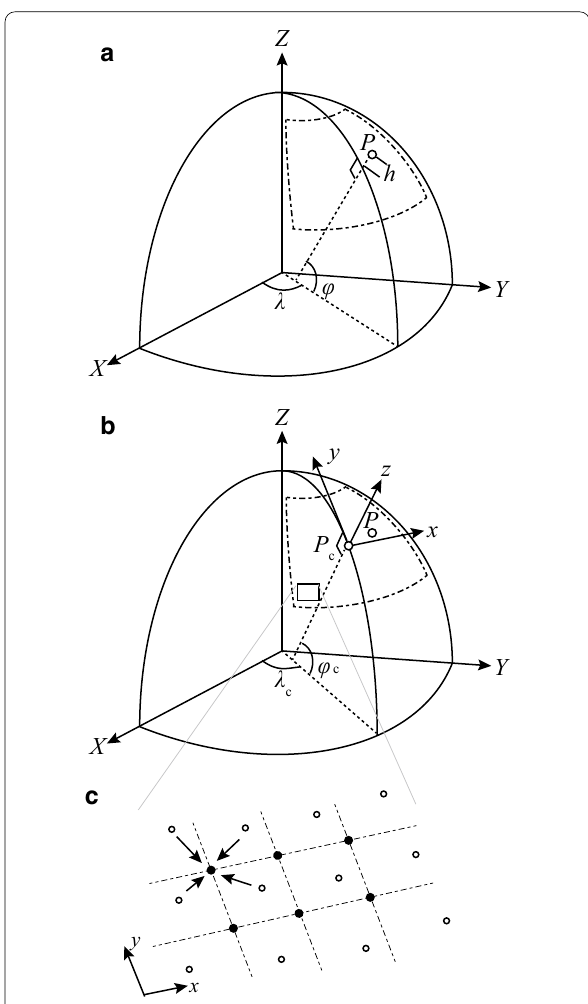
Fig. 1 Schematics of the coordinate transformation. For simplicity, 1/8 portion of the GRS80 reference ellipsoid is visualized. a Transformation of the coordinate of P from the geographical coordinate system to the ECEF system. Notably, P is located at the ellipsoidal height h . Because the region for the input data is defined in a rectangle area in the geographical coordinate system, it appears to be distorted in the ECEF system, as shown by the area surrounded by the dotted-dashed lines. b Transformation of the coordinate of P from the ECEF system to a local Cartesian coordinate system in which the origin is located at P c . Assuming h c = 0 , P c is located on the surface of the GRS80 reference ellipsoid. c Generation of new data points denoted by the black circles that were aligned in an equally spaced structured grid in the x – y plane in the local Cartesian coordinate system. White circles are the data points in the original DEM data that are not aligned in an equally spaced structured grid in the local Cartesian system. The z components in the points of the black circles are interpolated from those of the white circles by using the near-neighbor algorithm, as denoted by